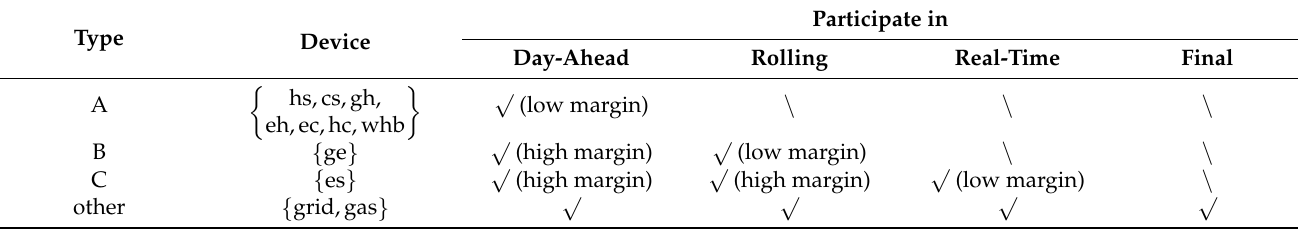
Table 1. Different types of